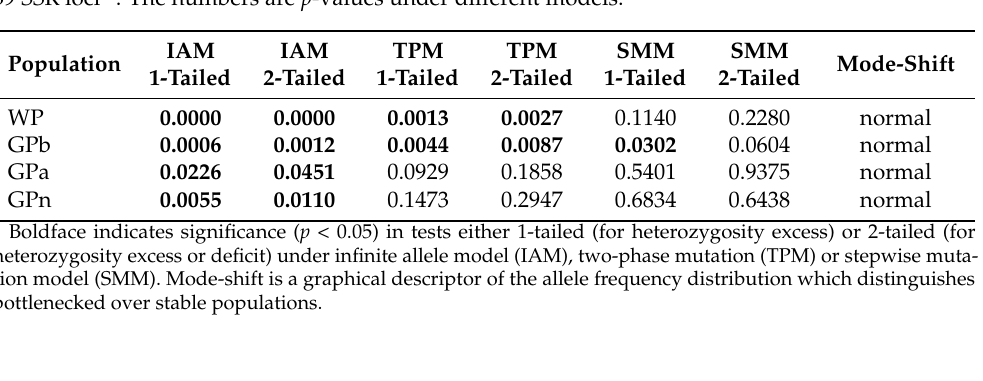
Table 3. The Wilcoxon’s tests for bottleneck of N. shimadai populations in northern Taiwan across 39 SSR loci z . The numbers are p -values under different models.